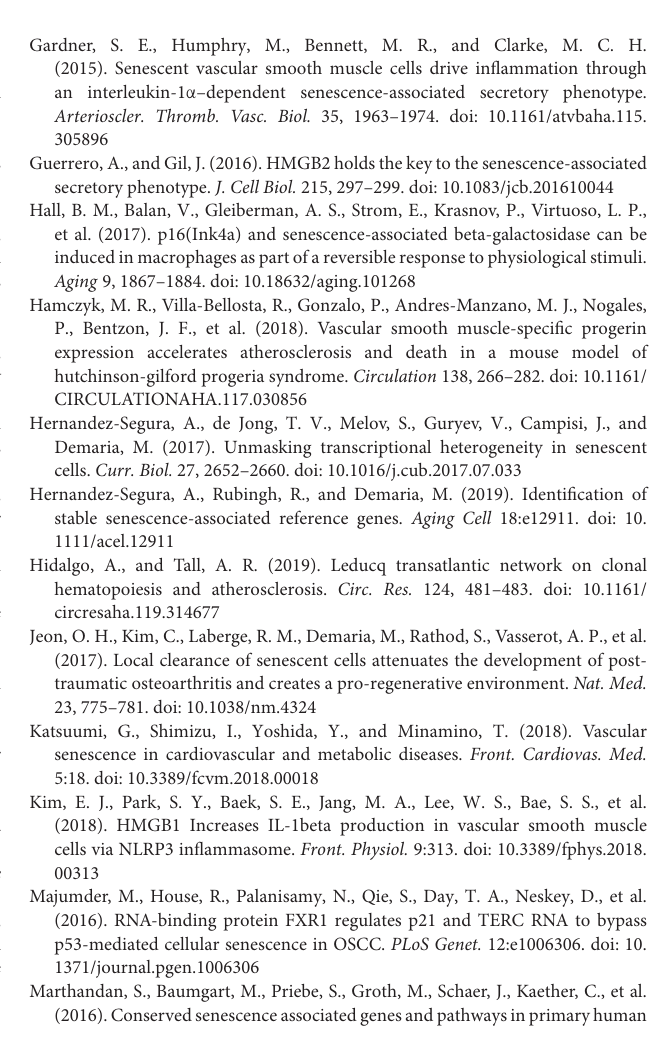
TABLE S1 | Proteomics dataset of NS vs RS